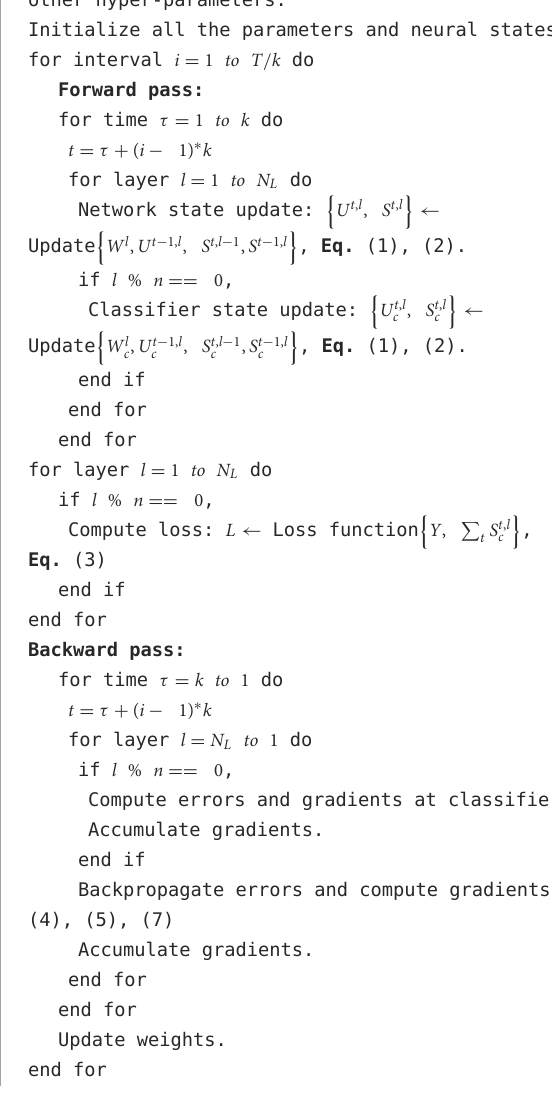
Algorithm 1. Training algorithm for one batch